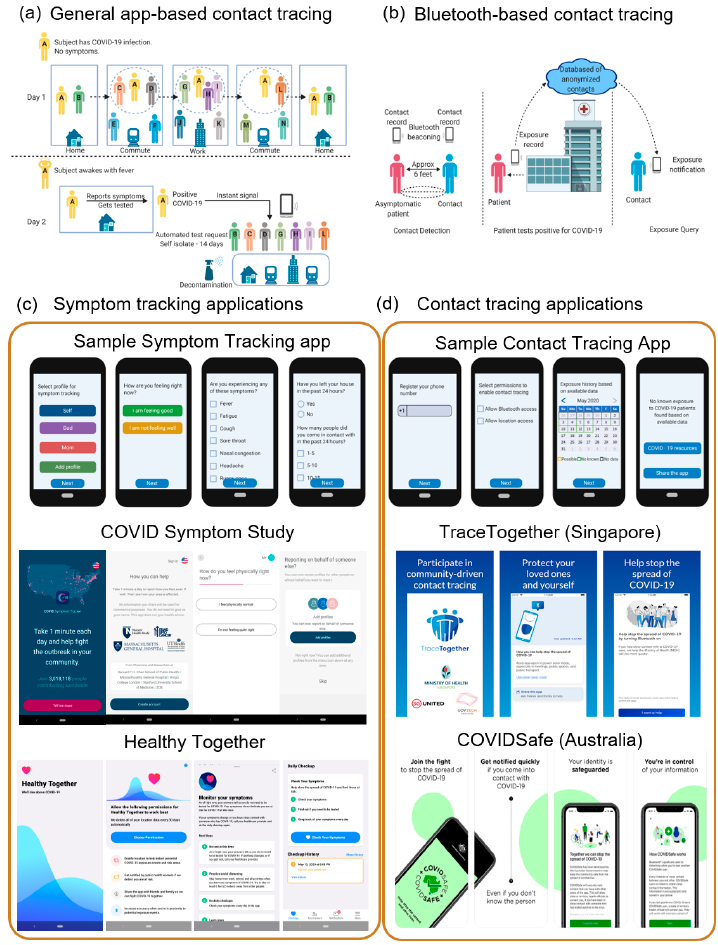
Figure 7. Digital monitoring tools of COVID-19 spread by online and cellphone applications. ( a ) General smartphone app-based contact tracing—the social encounters (distance less than 6 feet) of all the users are recorded by the app, using methods such as GPS information, QR code-tracking, and Bluetooth communication. An asymptomatic patient could infect others in their family, commute, or workplace. The patient takes the COVID-19 test (using the app) when individuals show signs of symptoms, such as fever. When the patient tests positive, instant notifications are sent to individuals who could be infected by the virus. Individuals are asked to take the COVID-19 test and self-isolate themselves for 14 days. The places where the patient went before testing positive are also thoroughly disinfected to prevent the spread of the disease; ( b ) Bluetooth-based contact tracing, as proposed by the MIT Lincoln Laboratory, does not require personal information or location to be shared. The app keeps a record of Bluetooth signals it has encountered, along with information about the distance between the devices and duration for which other individuals were nearby. When a user tests positive, the app sends the contact record to the database of anonymized contacts, which then sends exposure notifications to the users who might have been in close contact with the patient. This app works in a privacy-sensitive manner, without revealing user information to other individuals and health authorities; ( c ) Examples of apps that use surveys to track the symptoms of users to monitor the prevalence of the disease and identify potential hotspots: screenshots from a generic symptom tracking app to show sample survey questions, COVID Symptom Study (by Massachusetts General Hospital, the Harvard T.H. Chan School of Public Health, King’s College London and Stanford University School of Medicine, working with ZOE—a health science company) and the Healthy Together (by State of Utah, USA); ( d ) Examples of contact tracing apps: screenshots from a generic contact tracing app to show user interface and o ffi cial government-developed apps—TraceTogether (Singapore) and COVIDSafe (Australia). These apps use Bluetooth-based contact tracing and provide region-specific healthcare guidelines and